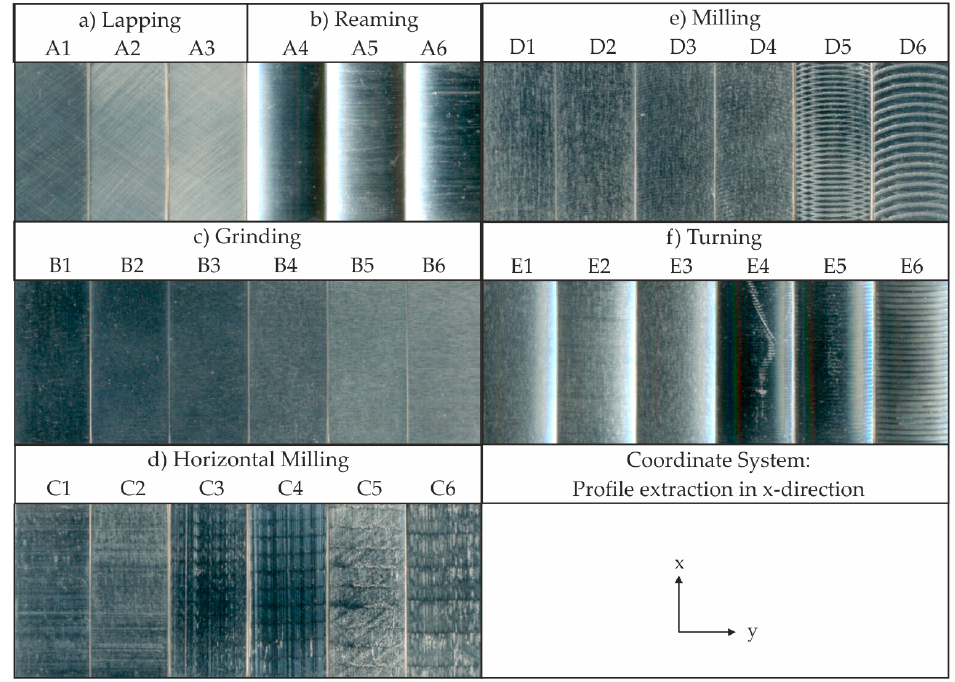
Figure 2. Examined samples of varying manufacturing principles: Six different processes with three and six roughness degrees are considered.